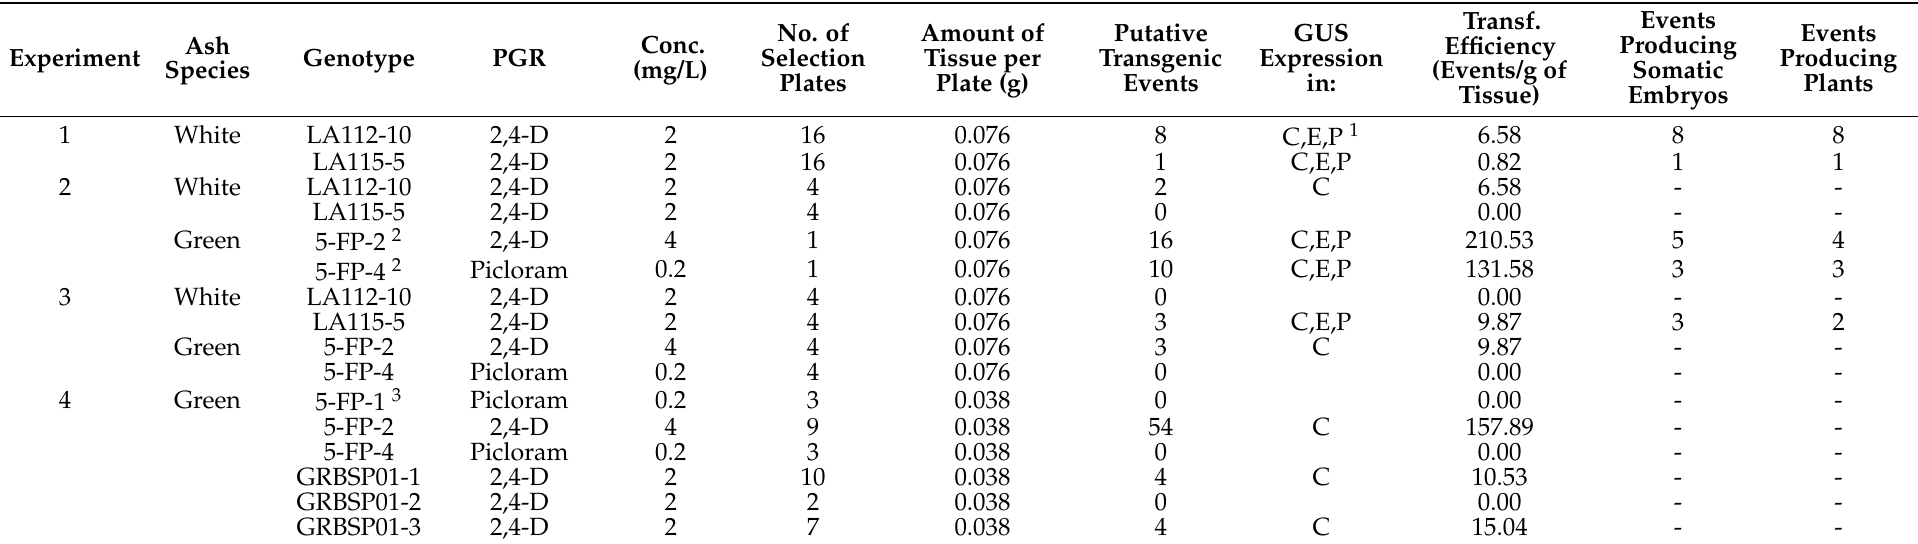
Table 1. Overview of Transformation Experiments